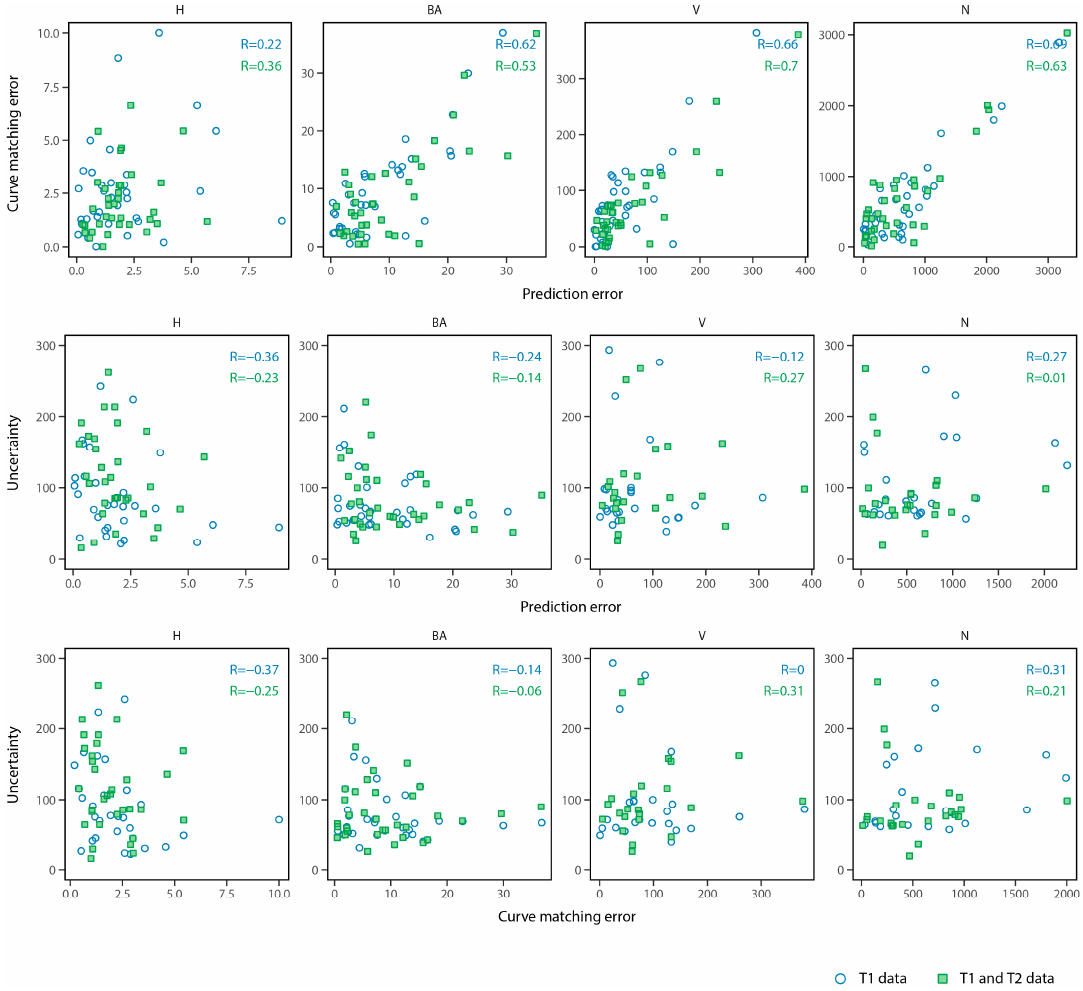
Figure 7. Relationship between prediction error, curve matching error, and uncertainty for the four plot-level attributes. H—top height, BA—basal area, V—total volume, N—stem density.